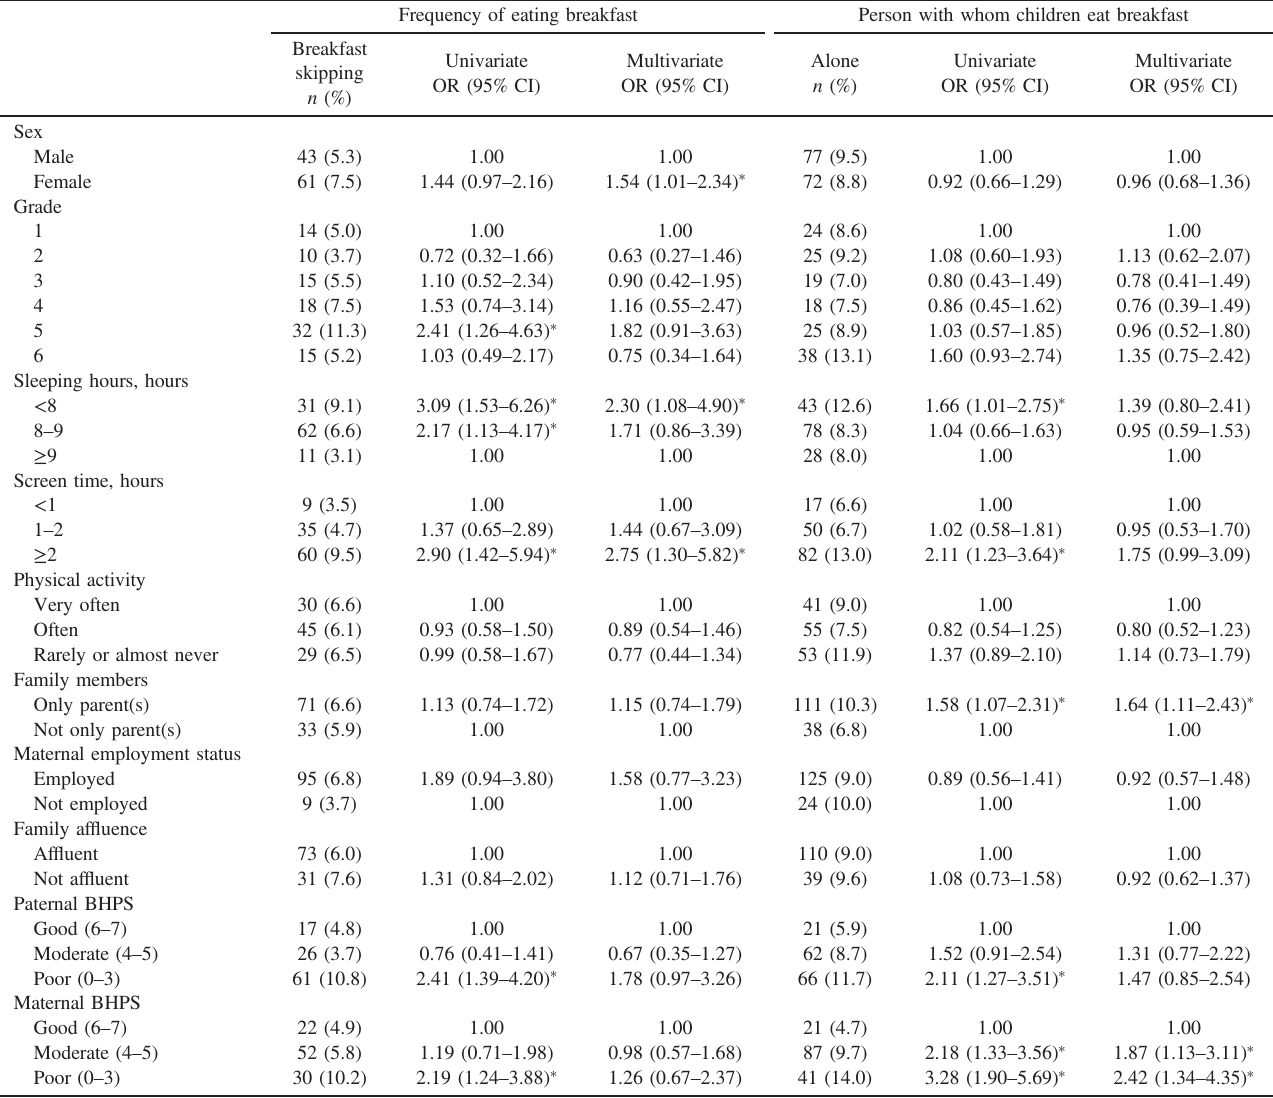
Table 3. The relationship between parental lifestyle factors and breakfast habits of children Frequency of eating breakfast Person with whom children eat